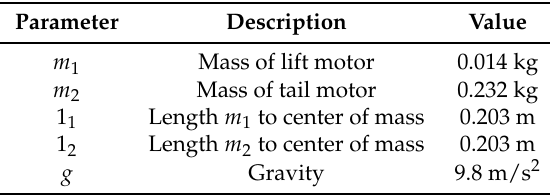
Table 4. Parameters used in the simulation results.